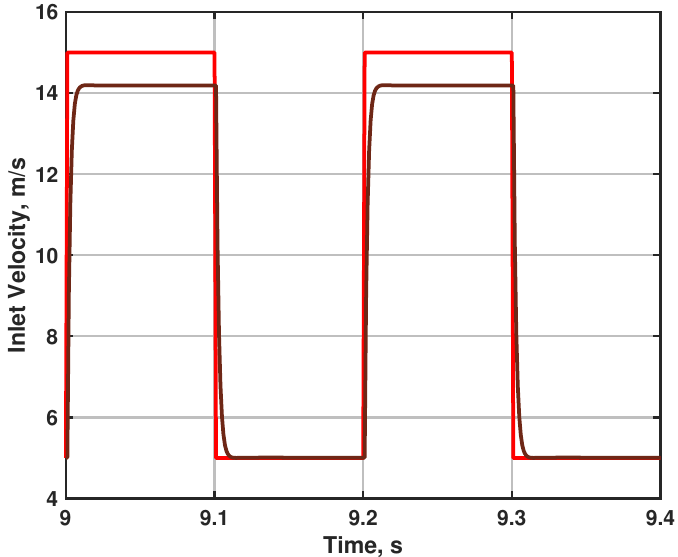
Figure 8. Resulting inlet velocity profiles over time as obtained in cases 2 (red) and 2B (brown). Another interesting feature of the pressure method is the intrinsic smoothness of the velocity variation upon a step change. Whereas case 2 exhibits a definitive step-like pattern in Figure 8, case 2B yields a smoother approach of the inlet velocity to the set values, both upon increases and decreases of the inlet pressure. The explanation behind this behavior